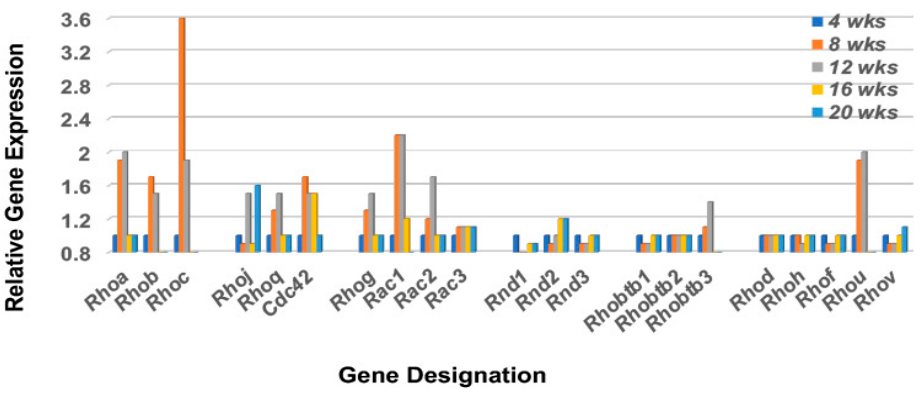
Figure 6. Transcriptomic profile of the Rho-GTP family of proteins in the lacrimal glands of C57BL/6.NOD- Aec1Aec2 mice. Rho-GTPase family proteins are important in regulating the cellular homeostasis of the GTP<>GDP system. The Rho-GTP family consists of 21 members of which 16 are divided among 5 subfamilies (Rsf1, Rsf2, Rsf3, Rsf4 and Rsf5) with 5 unassigned (designated Rsfx). For cells in the non-activated state, Rho-GTP molecules are mostly associated with cellular membranes, but during cell activation the molecules dissociate to the cytoplasm by an as yet unknown mechanism.